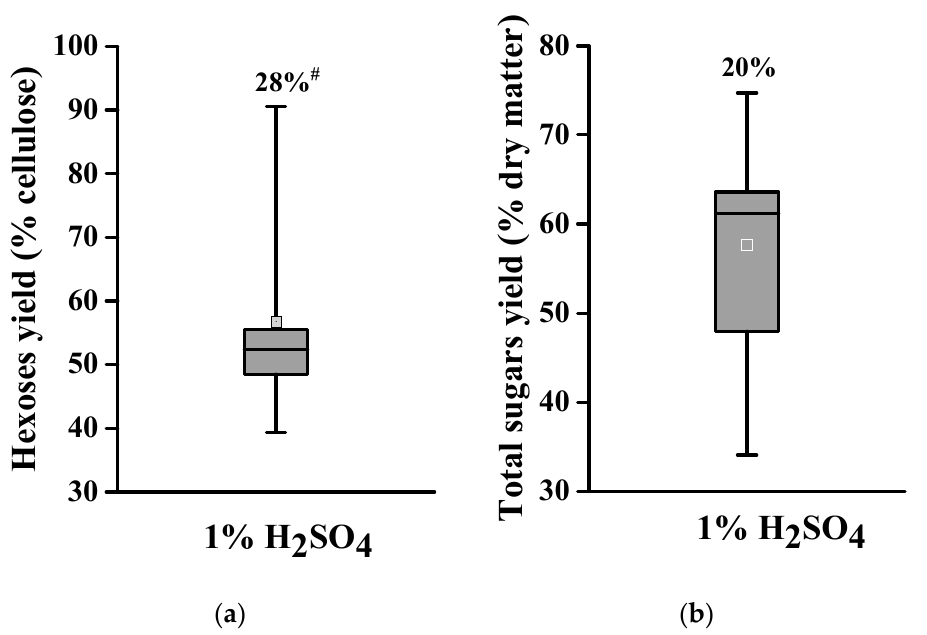
Figure 2. Variation of biomass enzymatic saccharification among 11 total banana samples after acid pretreatments ( n = 11). ( a ) Hexoses yields released from enzymatic hydrolysis after 1% H 2 SO 4 pretreatment; ( b ) total sugar yields (hexoses and pentoses) released from both enzymatic hydrolysis and 1% H 2 SO 4 pretreatment; # As coefficient of variation.